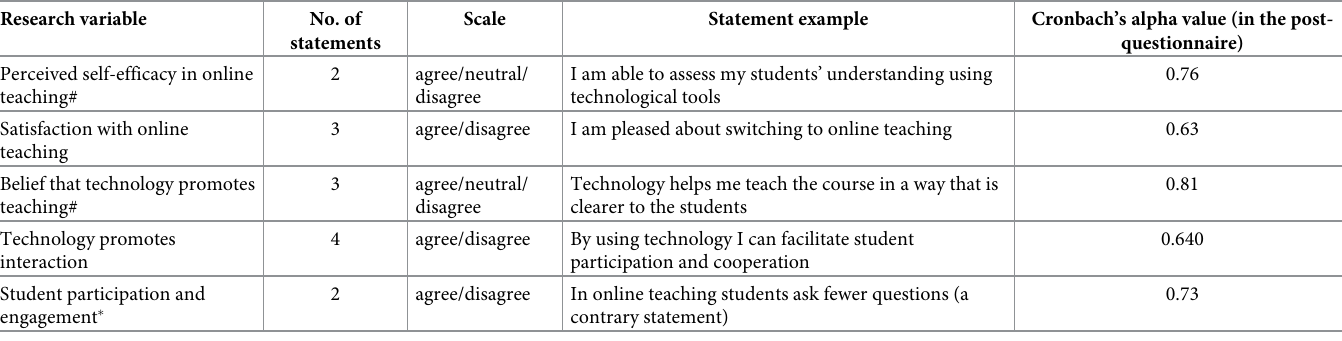
Table 2. Lecturer questionnaires: Views regarding online teaching: Research variables, example statements, and Cronbach’s alpha values. Research variable